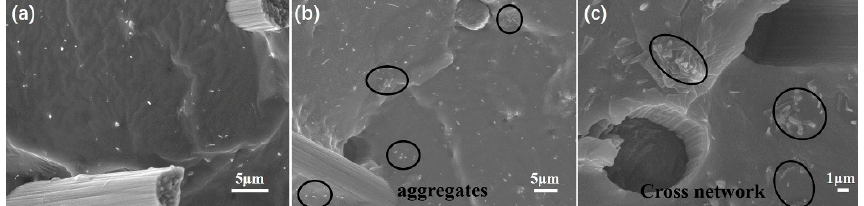
Figure 4. Morphology evolution of PDMS/SCF (8 wt %)-CNT (1 wt %) composites: ( a ) homogeneous dispersion of CNT and SCF in PDMS before compression; ( b ) the free assembly network under compression; ( c ) forced assembly network under spatial confining compression.